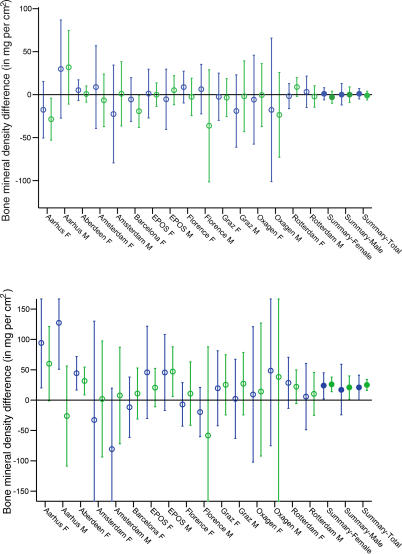
Association between
COLIA1 Alleles and BMD
Differences in BMD (in mg/cm
2) for the contrasts of GG homozygotes versus GT heterozygotes are shown in the top panel and those for GG and GT combined versus TT homozygotes in the bottom panel. For each study, the point estimates and 95% CIs for the differences in BMD in the lumbar spine (blue) and femoral neck (green) are shown. The figures are purposely drawn putting data on the two skeletal sites side by side in each center for comparison. Summary estimates of the differences and their 95% CIs are given by random effects models for male (M), female (F), and all participants (total). Fixed effects estimates are very similar (not shown). Filled circles represent summary estimates.